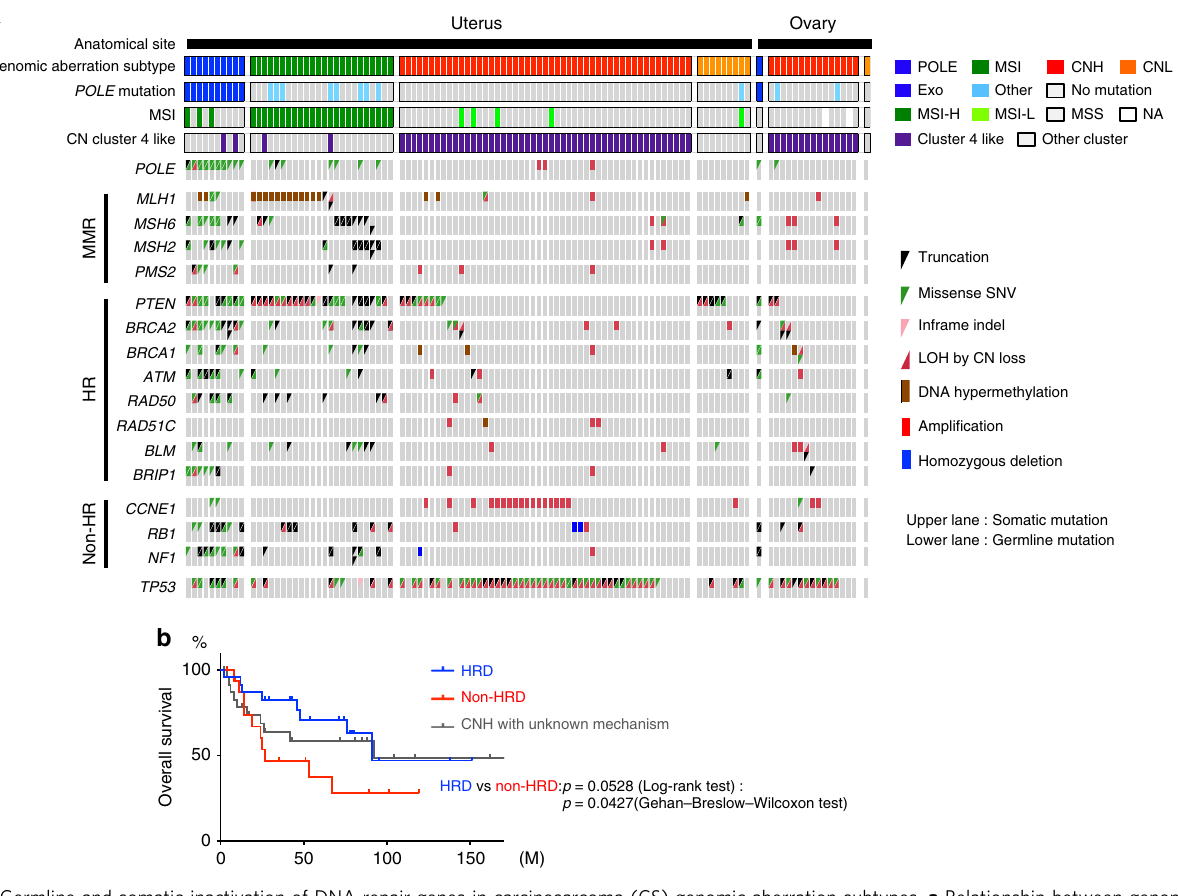
Fig. 2 Germline and somatic inactivation of DNA repair genes in carcinosarcoma (CS) genomic aberration subtypes. a Relationship between genomic aberration subtype and DNA repair gene mutation. Status of inactivation of POLE , mismatch repair (MMR), and homologous recombination (HR) genes are sorted according to CS subtype and shown along with mutational status of TP53 using Oncoprint. Color code is as follows: truncating mutation, black triangle; missense SNV, green triangle; in-frame indel, pink triangle; loss of heterozygosity (LOH) in wildtype allele by copy-number loss, red triangle; promoter hypermethylation, brown rectangle; ampli fi cation, red rectangle; and homozygous deletion, blue rectangle. Somatic and germline mutations are shown in the upper and lower rows, respectively. Using Oncoprint, we show germline missense SNVs only when pathogenic or likely pathogenic, as according to the American College of Medical Genetics and Genomics, Association for Molecular Pathology (ACMG) guidelines (see Methods). Note